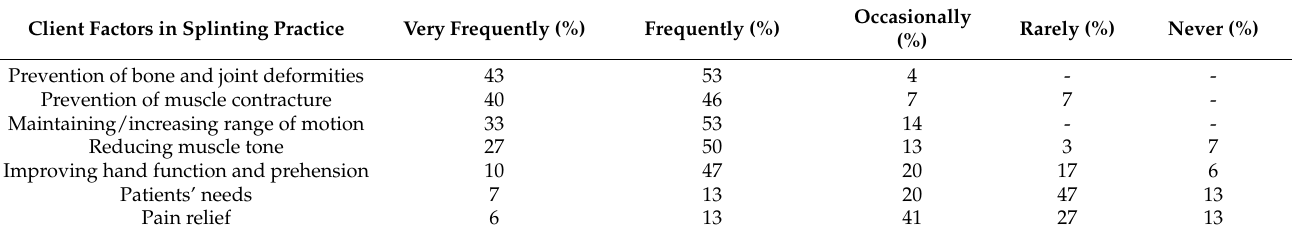
Table 4. Client factors in splinting practice ( n =